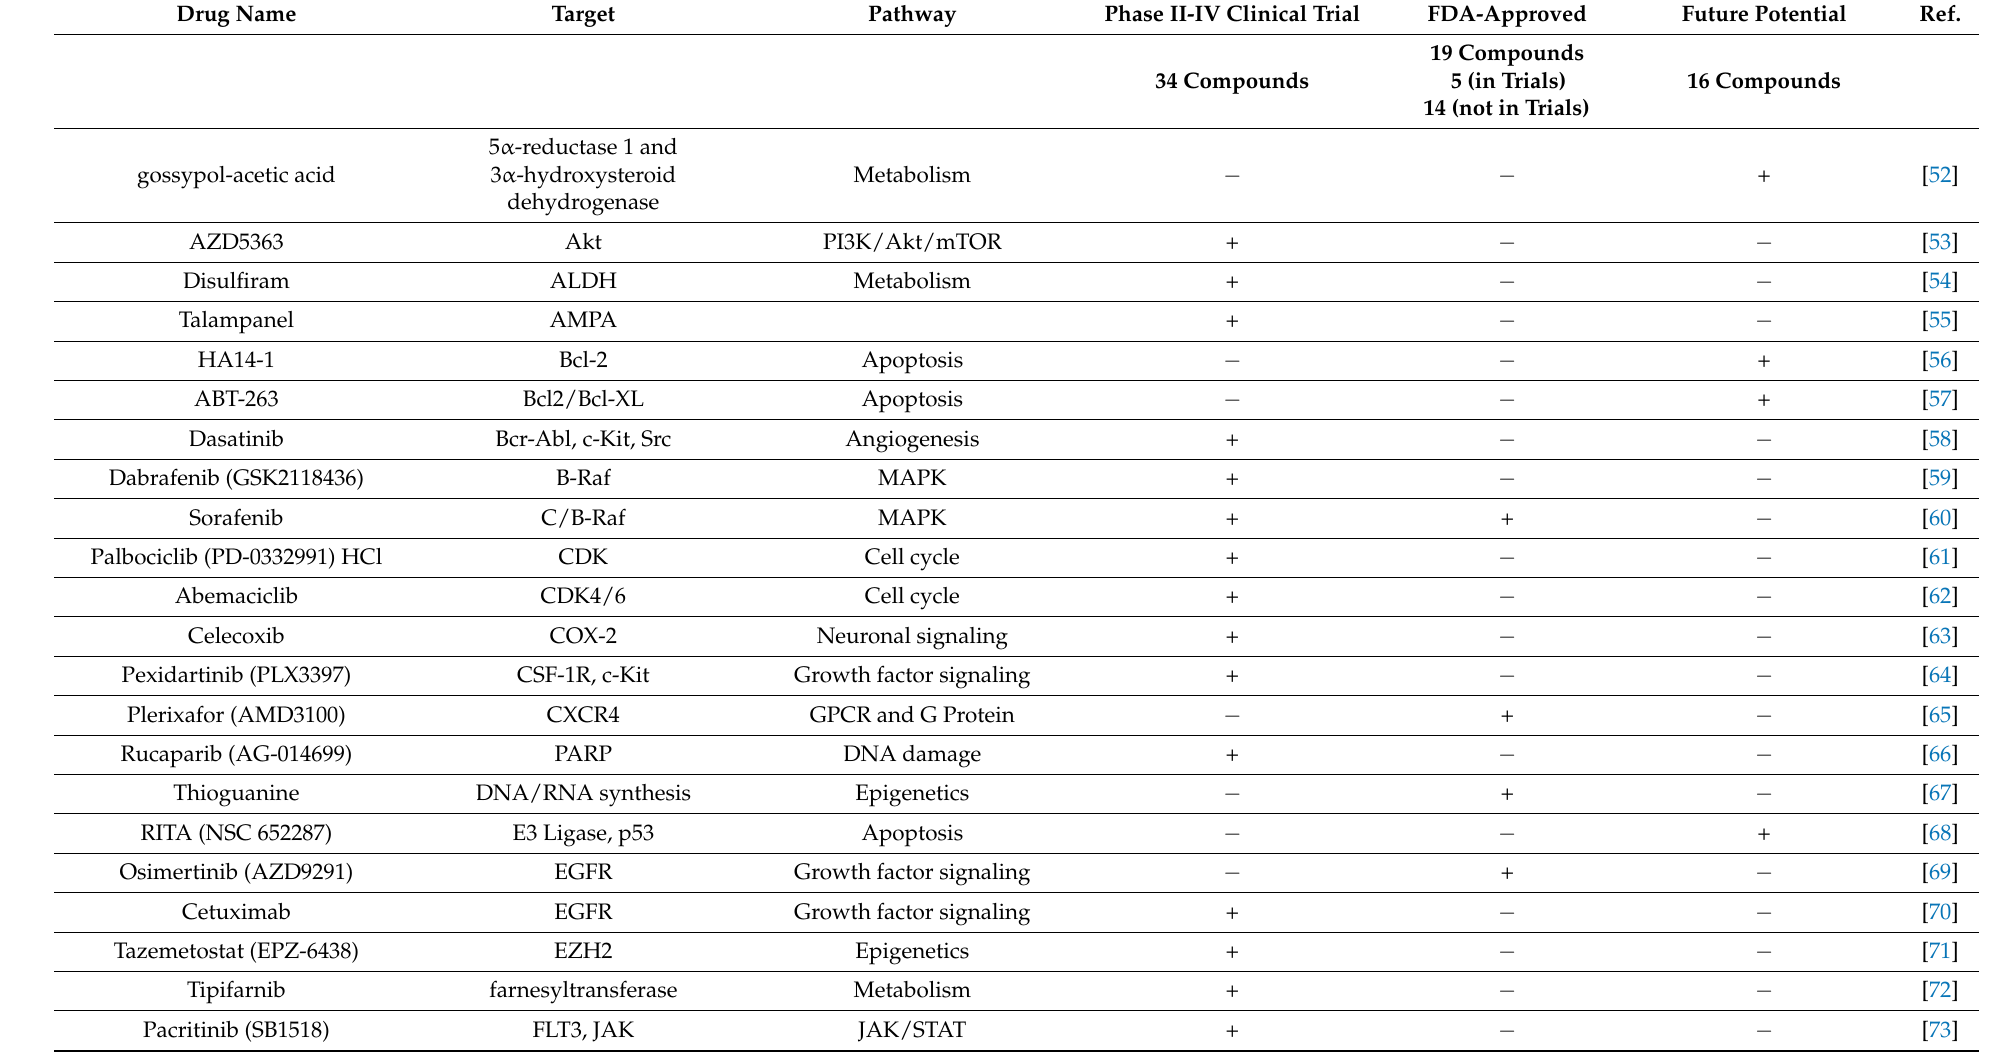
Table 1. List of selected drugs with their respective molecular target, signaling pathway and clinical